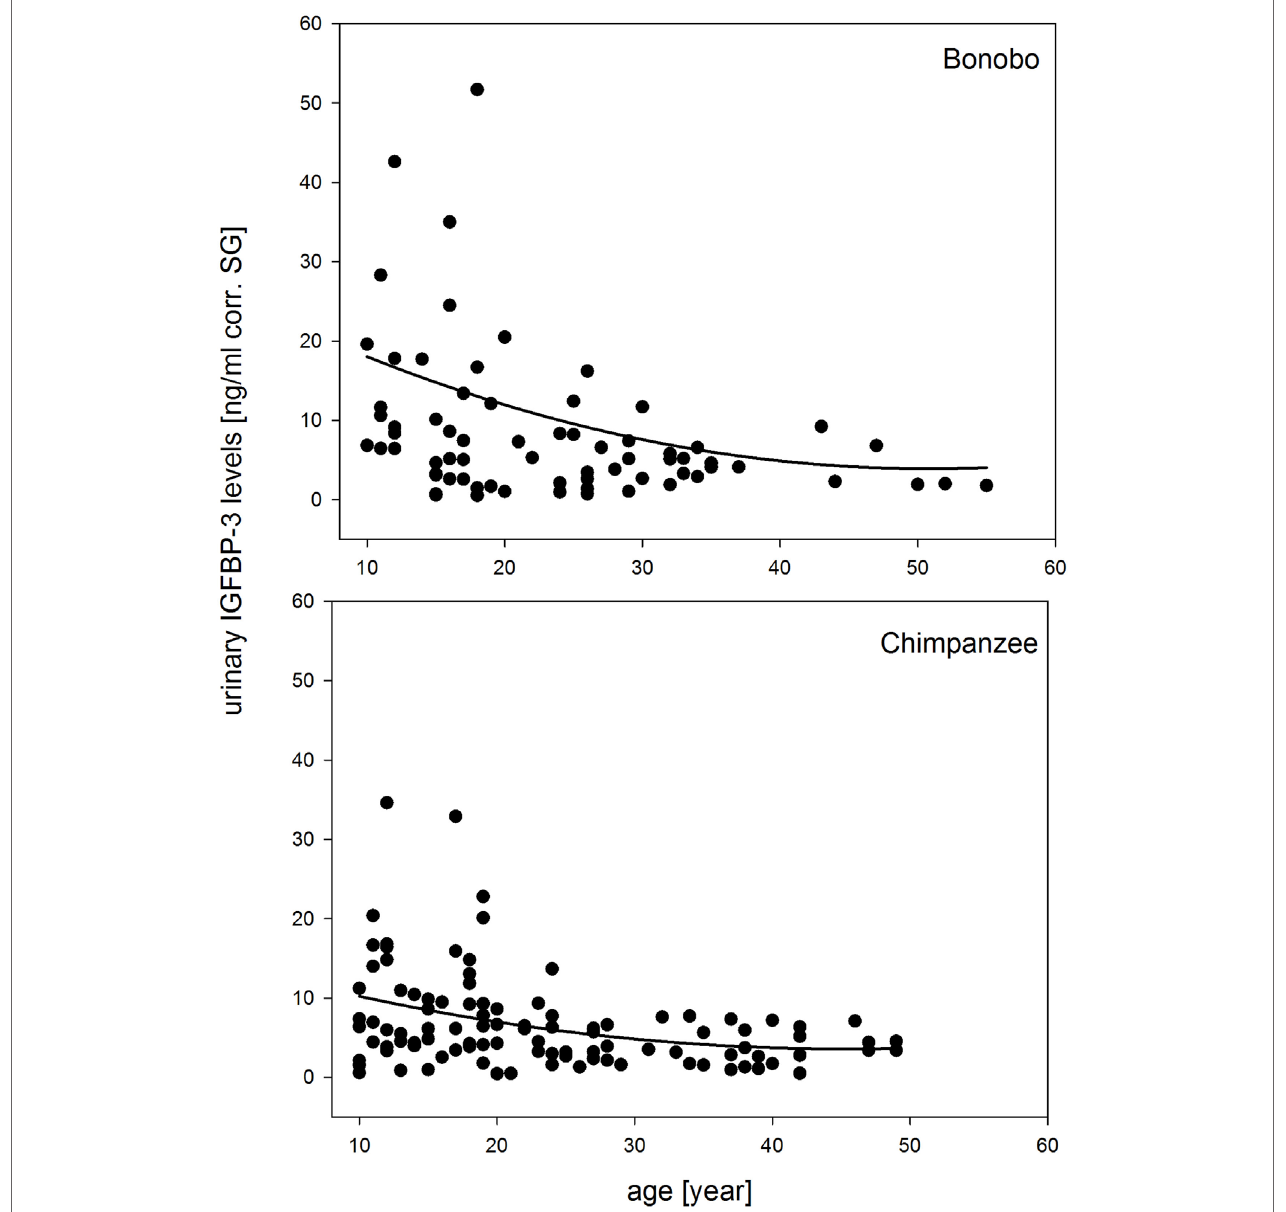
FigUre 1 | Measures of urinary igFBP-3 levels corrected for specific gravity (corr. sg) from bonobos (upper plot) and chimpanzees (lower plot) in relation to chronologic age . Sample sizes: N bonobos = 71 (31 males, 40 females), N chimpanzees = 102 (33 males, 69